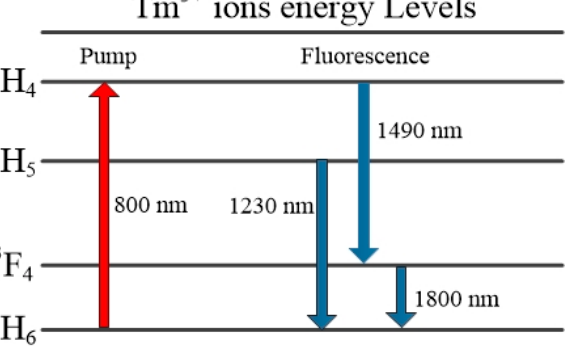
Figure 11. Energy level diagram of Tm 3+ ions.